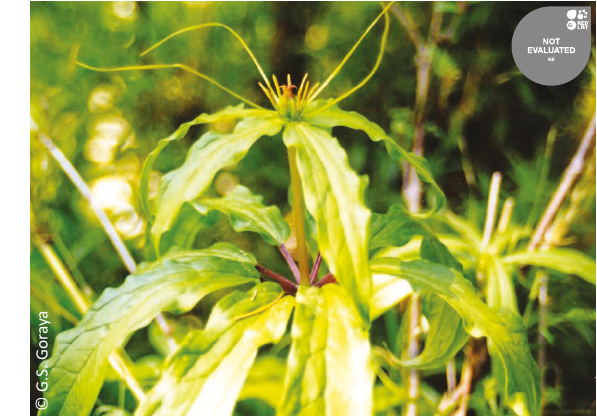
Image 28. Paris polyphylla Sm.